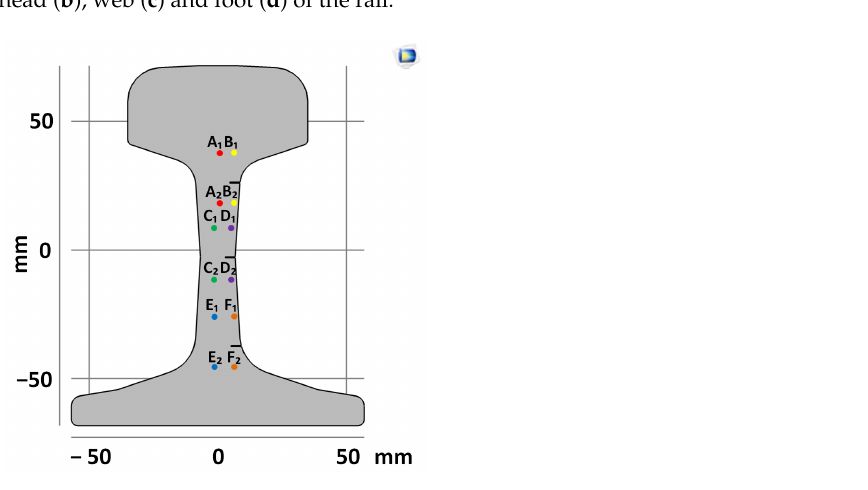
Figure 5. Displacement distributions obtained by DIC (upper row) and FEM (lower row) for the sample without incision ( a ) and with incision in the head ( b ), web ( c ) and foot ( d ) of the rail.